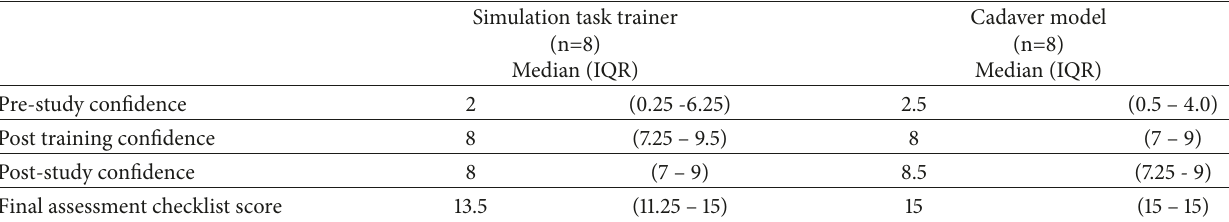
Table 4: Confidence